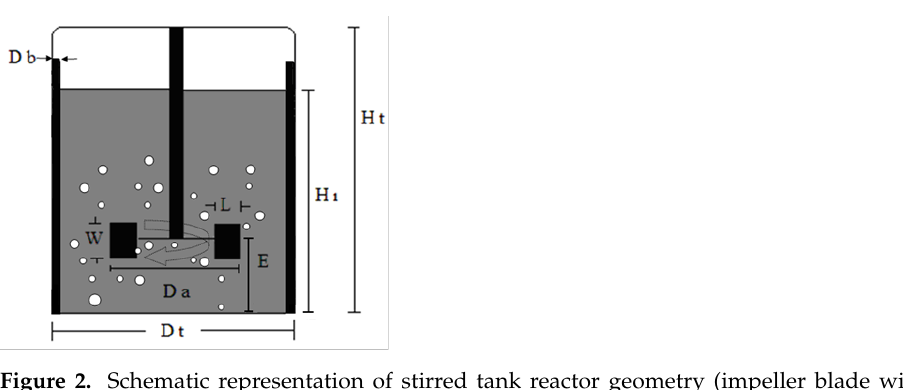
Figure 2. Schematic representation of stirred tank reactor geometry (impeller blade width (L), impeller blade height (W), diameter of impeller (Da), distance between middle of impeller blade and bottom of reactor (E), diameter of baffles (Db), diameter of tank (Dt), height of liquid in reactor (Hl), height of reactor (Ht)). Table 1. Dimensions of stirred tank bioreactor used.